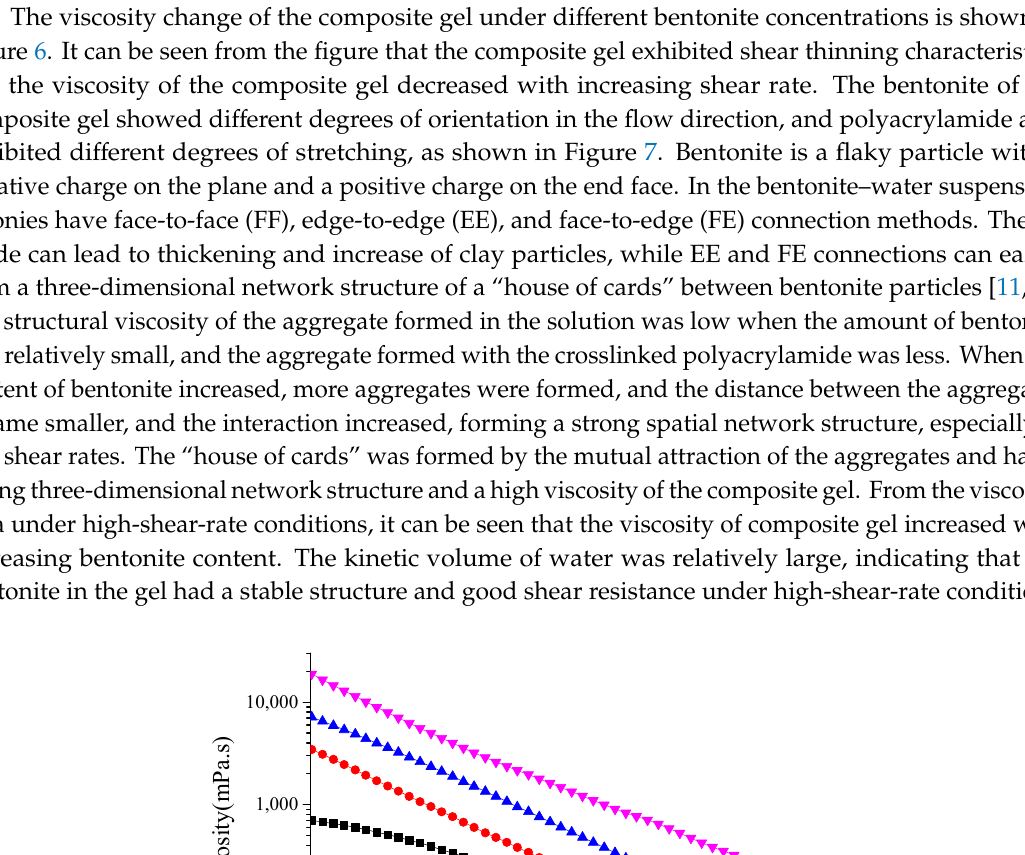
Figure 7. Internal structure changes under shear flow of composite gel. The viscosity change of the composite gel under different crosslinker concentrations is shown in Figure 8. It can be seen from the figure that the composite gel formed by different concentrations of the crosslinking agent still exhibited shear thinning characteristics after shearing. The viscosity of the composite gel formed by the high-concentration crosslinking agent is relatively lower than that of the low-concentration crosslinking agent. This is because the structure of the composite gel formed by polyacrylamide adsorbed on the betonies at a low concentration of the crosslinking agent. The polyacrylamide was partially adsorbed on bentonie, and the rest can be extended in water. Therefore, the viscosity of the gel was formed by the structure of betonies and the structure of entangled polyacrylamide in aqueous solution. Under these conditions, the composite gel had a higher viscosity at a low shear rate, and the shear thinning performance was more obvious at a high shear rate. When the crosslinking agent concentration was increased, the polyacrylamide crosslinked and formed aggregate with betonies. The structures of the composite gel were gradually transformed into bentonie as the structure mainly formed, and the structure formed by the intercalation of polyacrylamide in aqueous solution was decreased. Owing to the reduced structure of polyacrylamide stretching in aqueous solution and the volume of aggregate with bentonite becoming large after crosslinking, the viscosity of the composite gel decreased at a low shear rate and increased at a high shear rate.